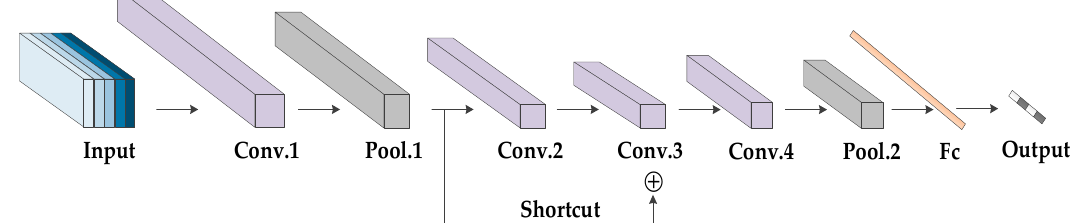
Figure 8. The structure of single-channel three-dimensional convolutional neural network (SC-3DCNN).